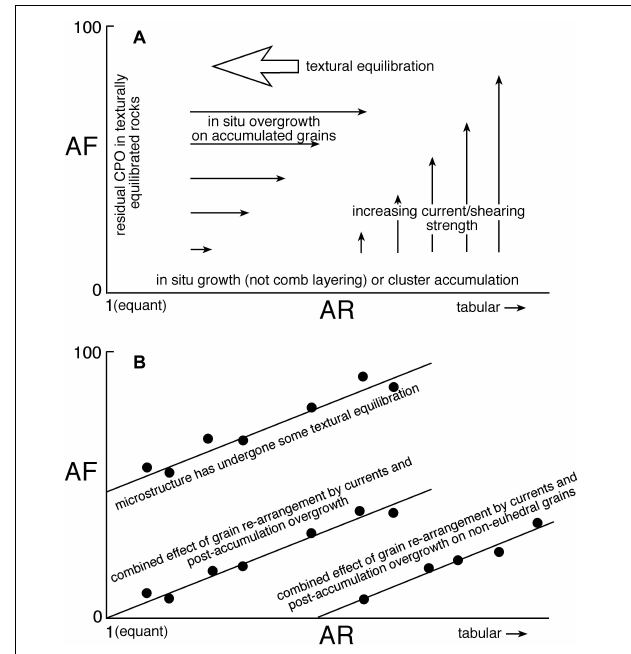
FIGURE 2 | Schematic diagrams of the relationship between fabric strength defined by a shape preferred orientation (SPO, quantified by the alignment factor, AF, which has a value of 0 for randomly aligned grains and a maximum value of 100 for perfectly aligned grains) and the average apparent aspect ratio (AR). (A) Rocks with no preferred shape orientation (AF = 0) form predominantly during in situ nucleation and growth, or by the accumulation of grain clusters. Positive correlations between alignment factor (AF) and average apparent aspect ratio (AR) can be achieved in two ways: firstly, an increasing fabric strength in a melt-bearing mush results in an increased AR during subsequent solidification, since no growth can occur on faces in contact with other grains (Brown, 1956); secondly, for any given strength of current, particles with higher AR will be re-arranged and aligned to form a stronger preferred alignment. Rocks with entirely equant grains (AR = 1), but with a residual SPO recorded by a crystallographic preferred orientation (i.e., with AF > 0 if defined using CPO), must have undergone extensive textural equilibration. (B) Positive correlations between alignment factor (AF) and average apparent aspect ratio (AR) pass through the origin for systems in which particles are free to take any primary shape. Those passing through the y -axis must have undergone some textural equilibration, whereas those cutting the x -axis are realistic for natural systems in which any mineral grain has a limited range of